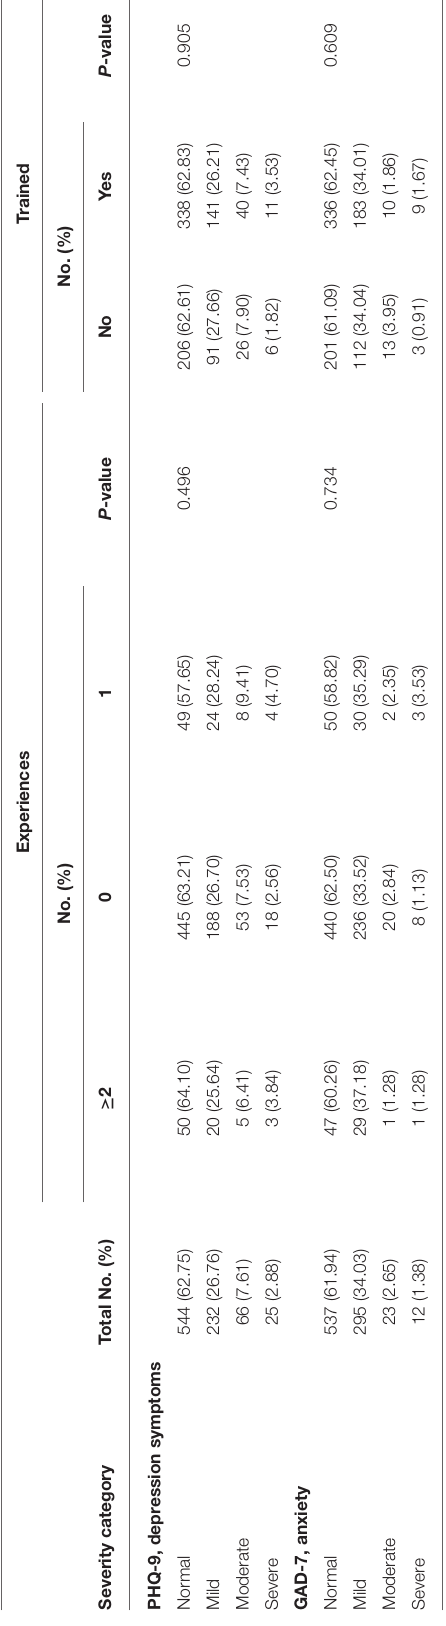
significant differences in working position, experience or not and training were noted for the scores of both depression and anxiety ( Table 3 ) [e.g., median (IQR) PHQ-9 scores among experienced ( ≥ 2) vs. inexperienced (0): 3.0 (1.0–5.25) vs. 3.0 (1.0–6.0); P = 0.857; median (IQR) GAD-7 scores among experienced ( ≥ 2) vs. inexperienced (0): 4.0 (2.0–6.0) vs. 4.0 (2.0–6.0); P = 0.961; median (IQR) PHQ-9 scores among trained vs. untrained: 3.0 (0.0–6.0) vs. 3.0 (1.0–6.0); P = 0.338; and median (IQR) GAD-7 scores among trained vs. untrained: 4.0 (2.0–6.0) vs. 4.0 (2.0–6.0); P =